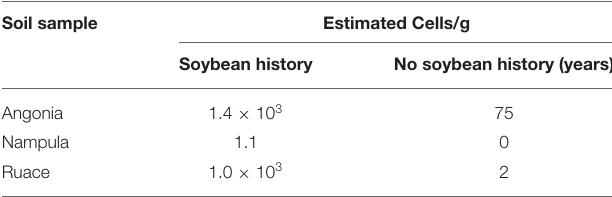
TABLE 2 | Soybean rhizobia most probable number (MPN) in soils collected from the experimental site with and without a history of soybean cultivation. Soil sample Estimated Cells/g Soybean